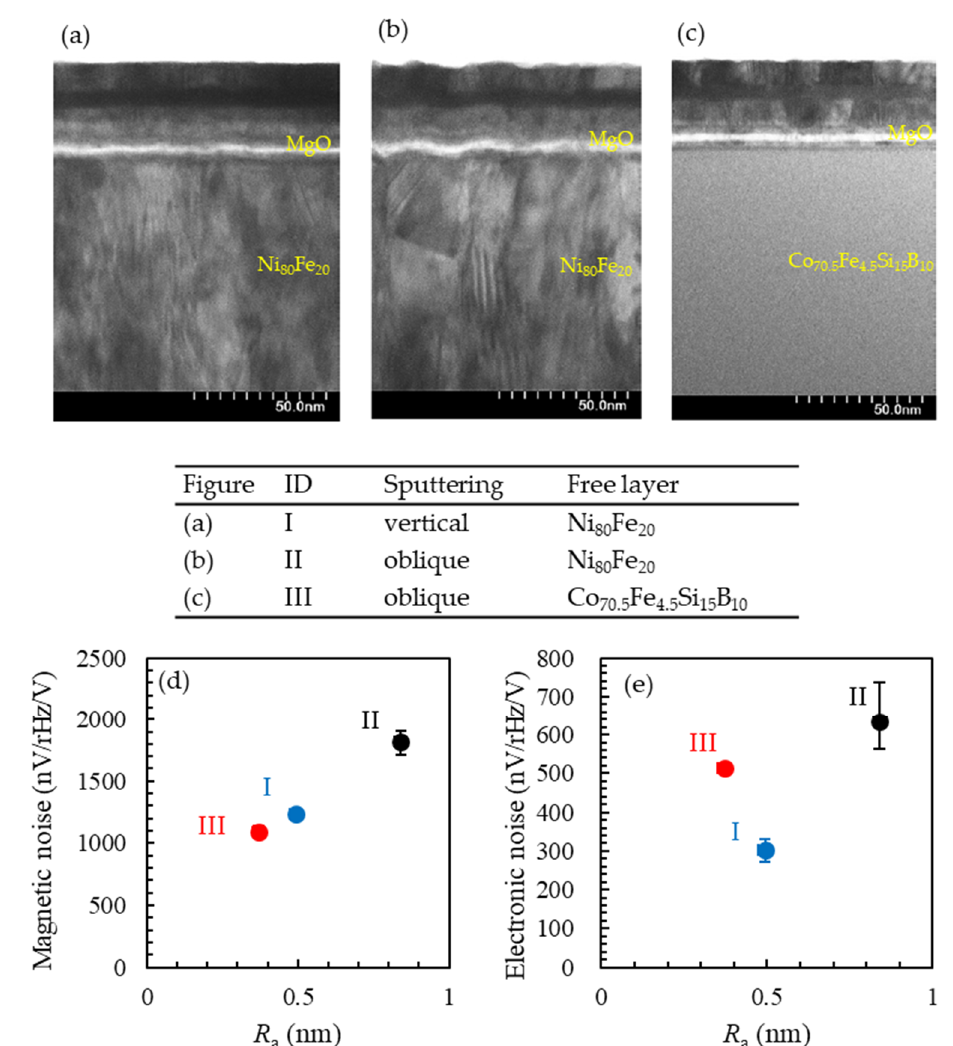
Figure A1. ( a – c ) Cross-sectional STEM image of TMR multilayers. The stacking structure of ( a , b ) is Sub. Si, SiO 2 /Ta 5/Ru 20/Ta 5/ free-layer 130/Ru 0.9/Co 40 Fe 40 B 20 3/MgO/Co 40 Fe 40 B 20 3/Ru 0.85/Co 75 Fe 25 2/ Ir 22 Mn 78 10/ Ta 5 / Ru 10 in nm. The table shows the configuration of